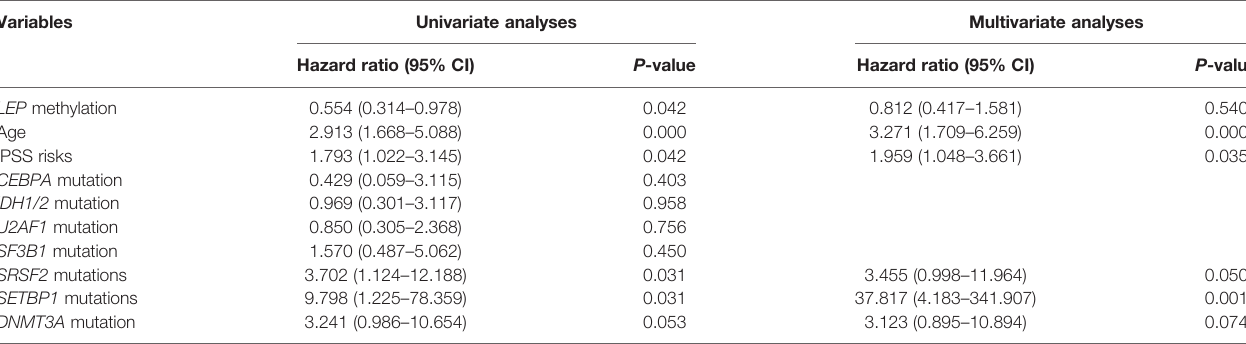
TABLE 2 | Cox regression analyses of variables for overall survival in MDS patients. Variables